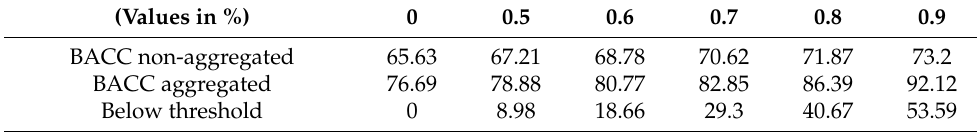
Table 4. BACC for various PQC thresholds and non-aggregated as well as aggregated classes. (Values in